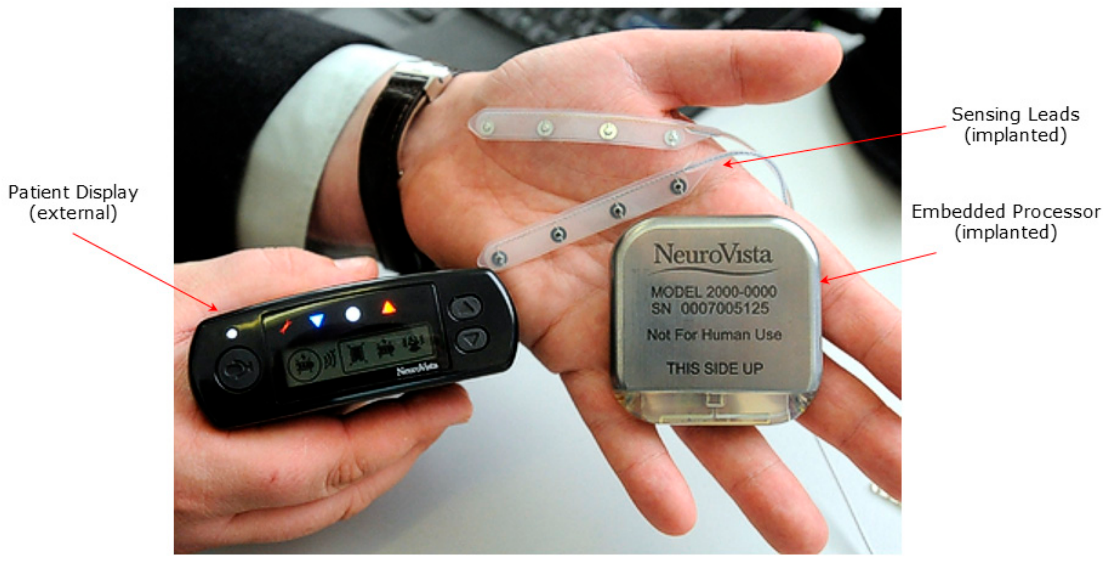
Figure 2. Seizure Advisory System (SAS) shown with implanted subdural electrodes, implanted EEG processor and telemetry unit, and external patent advisory module with red, white and blue indicator lights.